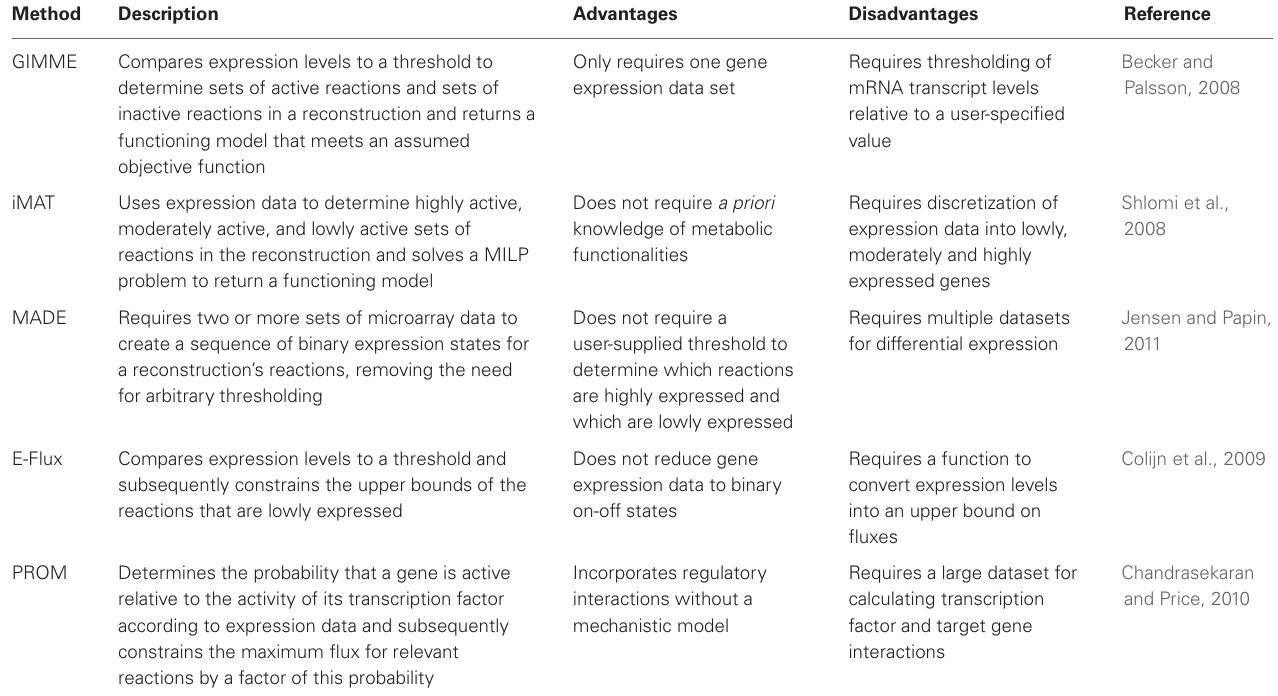
Table 1 | Summary of the algorithms for the integration of expression